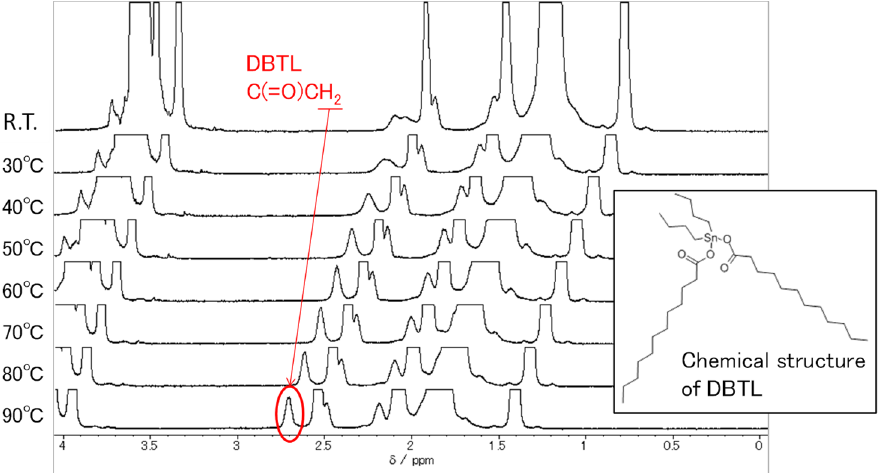
Figure 11. 1 H-NMR spectrum (E-212 with DBTL) at changing sample temperature.